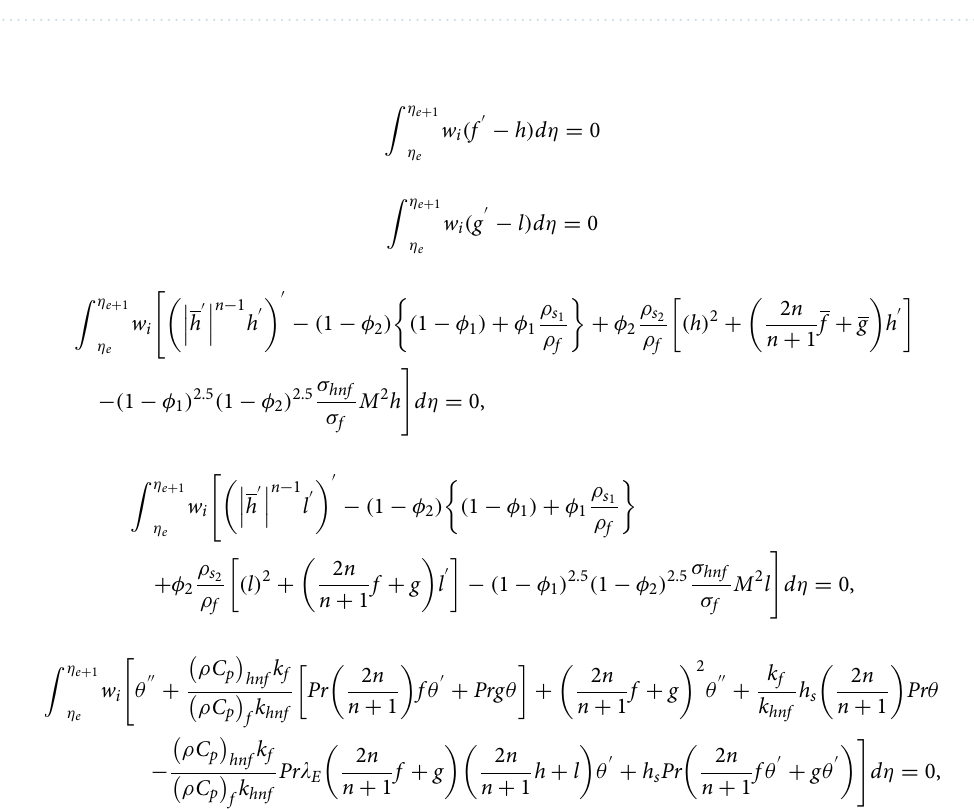
Table 2. Grid independent results when Pr = 204, (cid:31) E = 0.01, h s = 1.3, n = 2, M = 0.001, φ 1 = 0.004, φ 2 =